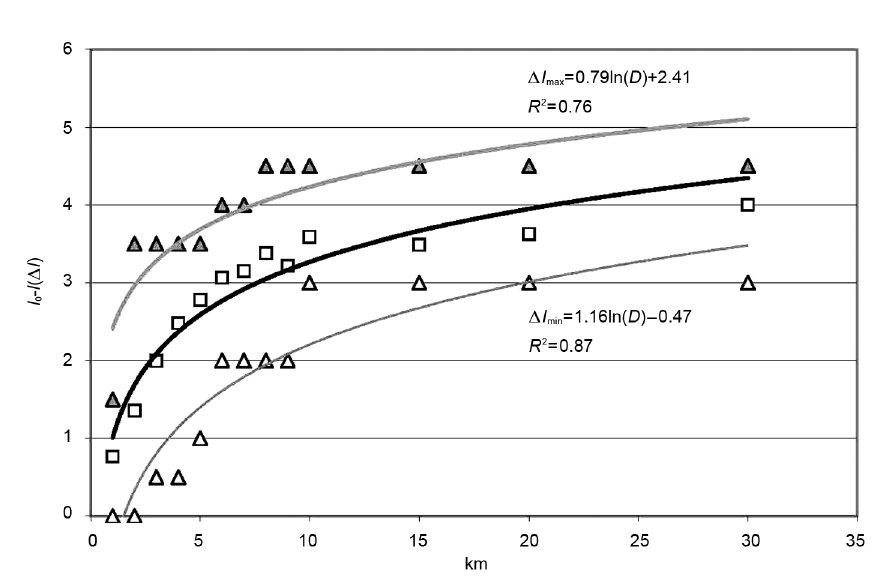
Fig. 8b. Best fits of the logarithmic relationships for maximum, minimum (grey and white triangles) and average values of attenuation; squares show the arithmetic average of ∆ I in fig.